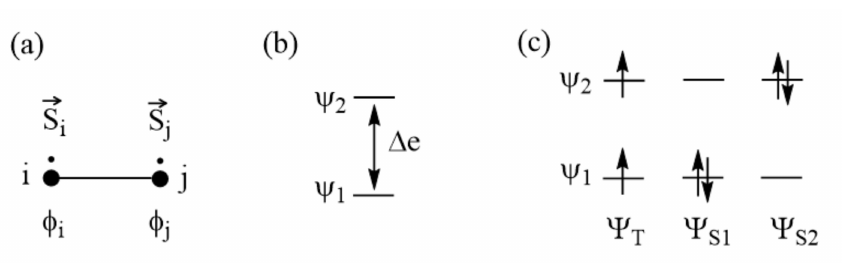
Figure 3. ( a ) Spin dimer made up of two S = 1/2 ions at sites i and j. Each site has one unpaired spin. The magnetic orbitals at the sites i and j are represented by φ i and φ j , respectively. ( b ) The bonding and antibonding states, Ψ 1 and Ψ 2 , resulting from the interactions between φ i and φ j , are split in energy by ∆ e. ( c ) The singlet and triplet electron configurations resulting from Ψ 1 and Ψ 2